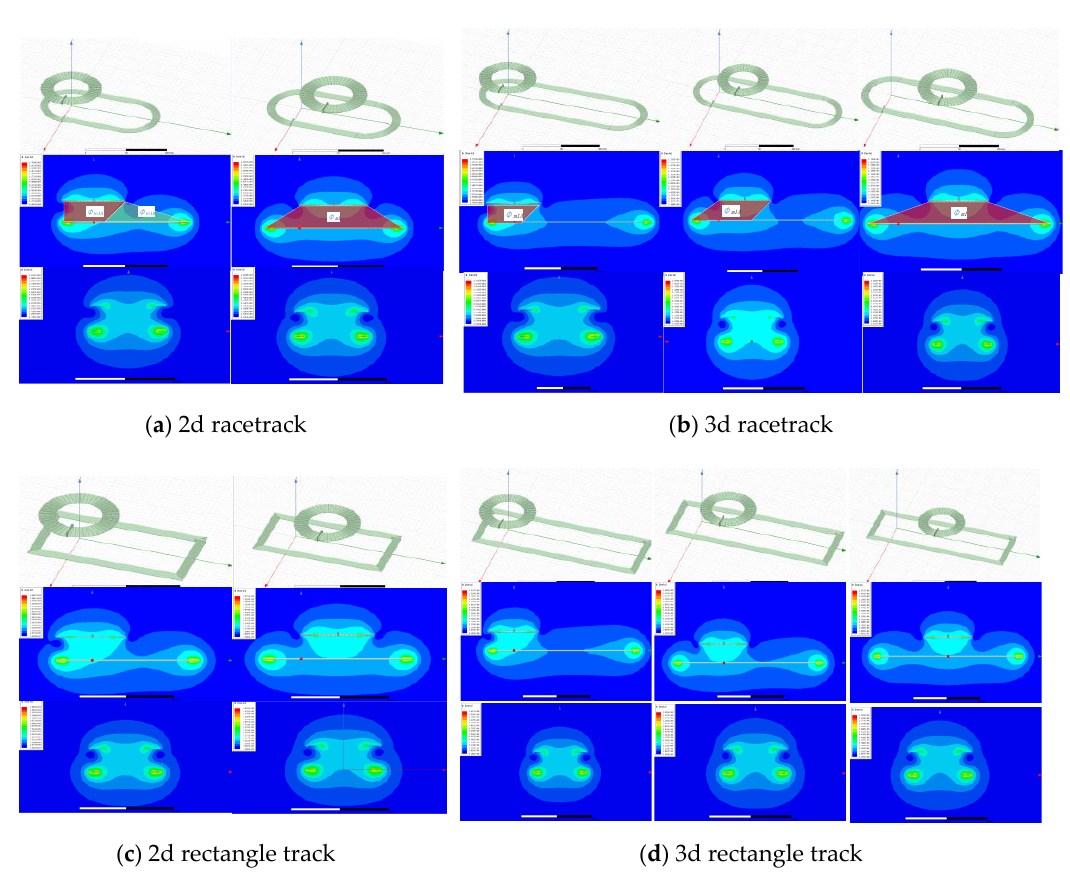
Figure 6. Models and magnetic distribution of racetrack and rectangle with 2d and 3d length. Table 2. Simulation related